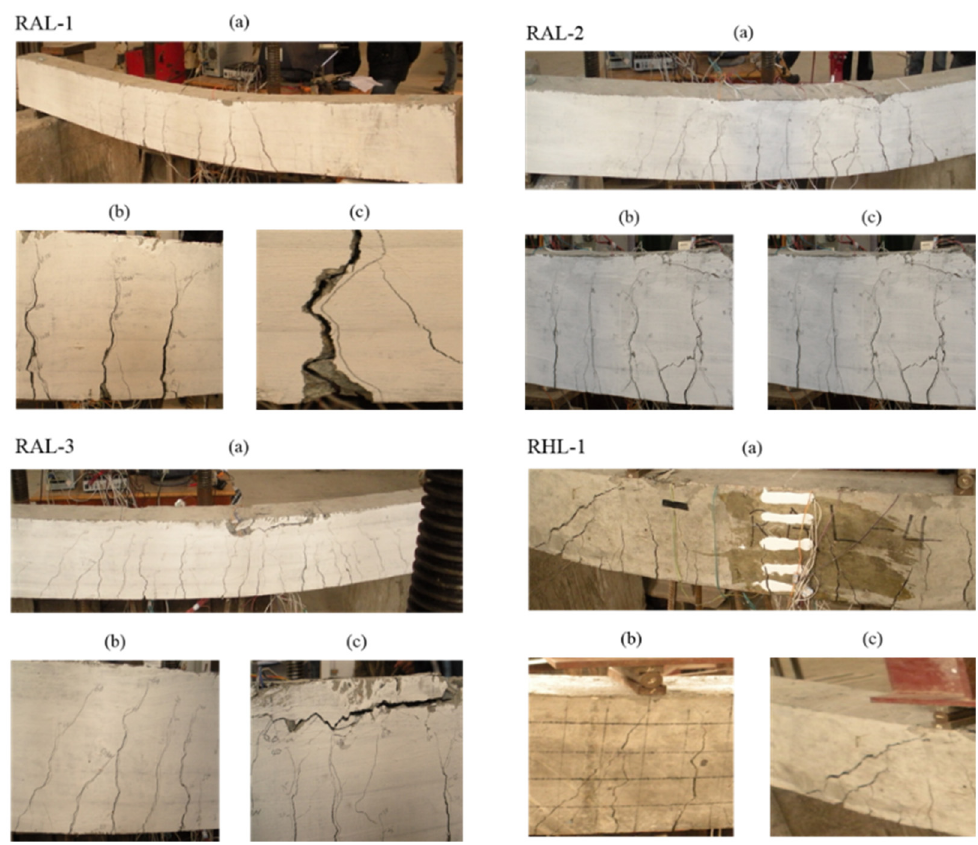
Figure 5. Test photos of RAL-1, RAL-2, RAL-3 and RHL-1. ( a ) Beam bending deformation, ( b ) Distribution of major fractures, ( c ) Crushing failure of concrete.